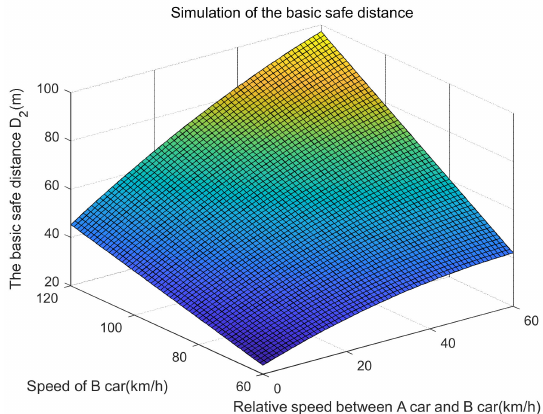
Figure 7. Changes in the basic safe distance D 2 with various V B and V r when i = 0.3 and d =